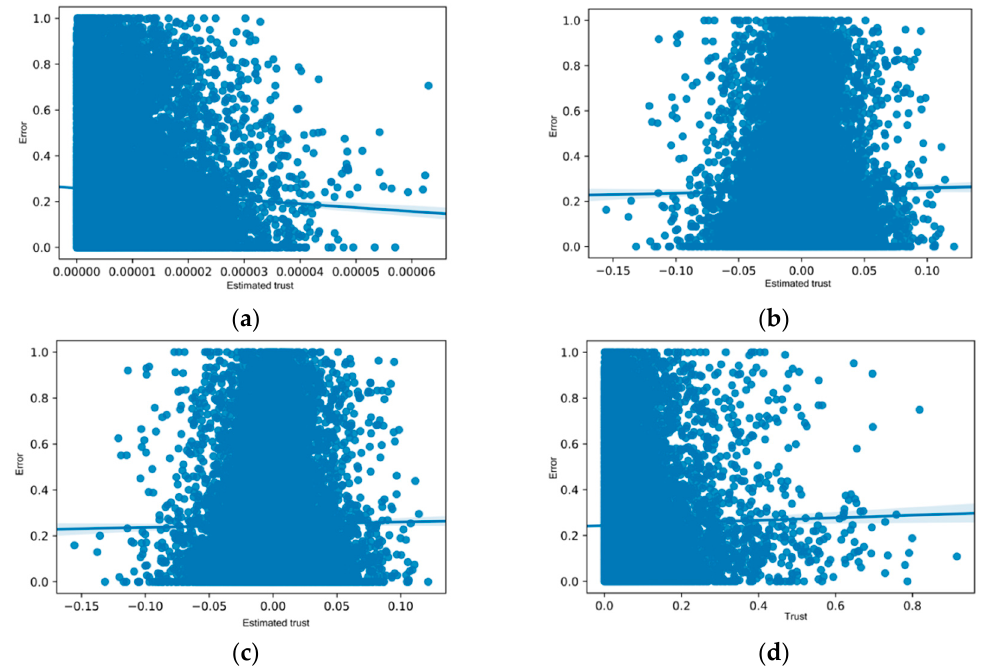
Figure 7. Errors in predictions versus trust (or estimated trust) for the ML-20m data set, as obtained by different methods: ( a ) Estimated trust against signed error in rating prediction using M-Trust; ( b ) Estimated trust against signed error in rating prediction using S-Trust; ( c ) Estimated trust against signed error in rating prediction using W-Trust; ( d ) Initial trust against signed prediction error for I-Trust.